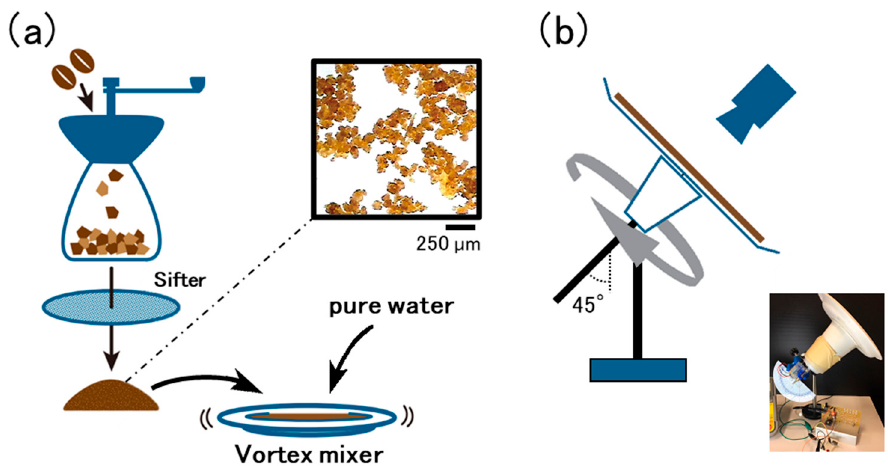
Figure 1. Experimental scheme. ( a ) Roasted coffee beans were ground with a conical burr grinder. Larger particles were sieved out of the ground powder with a sifter (grid size: 250 µ m). The ground coffee was mixed with pure water on a paper dish (diameter of the horizontal circular area: 140 mm), and the solution was spread over the whole dish by vibration with a vortex mixer. ( b ) Experimental apparatus to rotate the tilted dish with the solution containing the coffee particles. The paper dish with the coffee solution was fixed to a rotating dish with a tilting angle of θ = 45°. The dish was rotated at 60 rpm. During rotation, the whole experimental apparatus was situated inside a control box with constant humidity (60%) and temperature (20 °C).